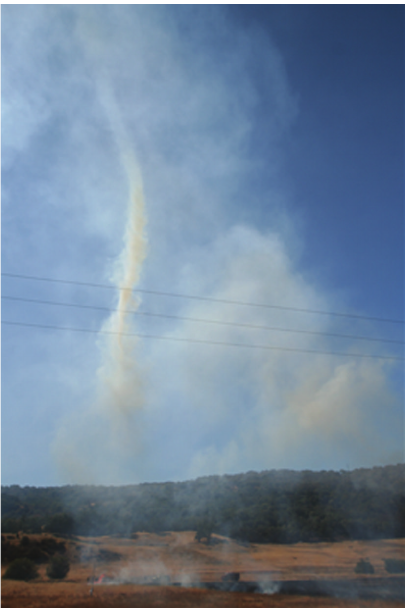
Figure 7: Photograph of dissipating fire whirl near the surface while rotating column is still active aloft (12:44PDT). Tower can be seen in the bottom of the